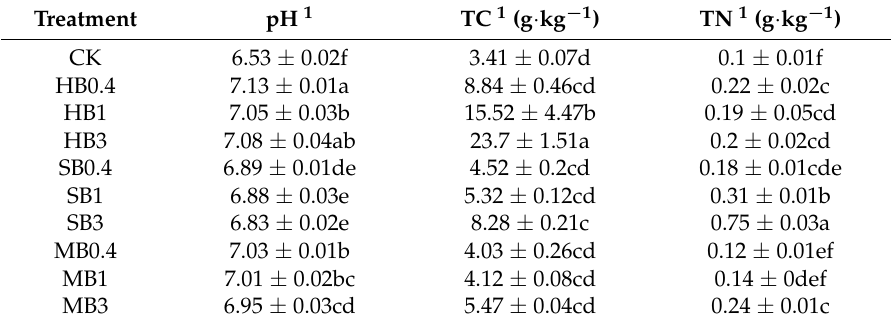
Table 3. Effects of HB, SB and MB treatments on pH, TC, and TN in mine tailings.